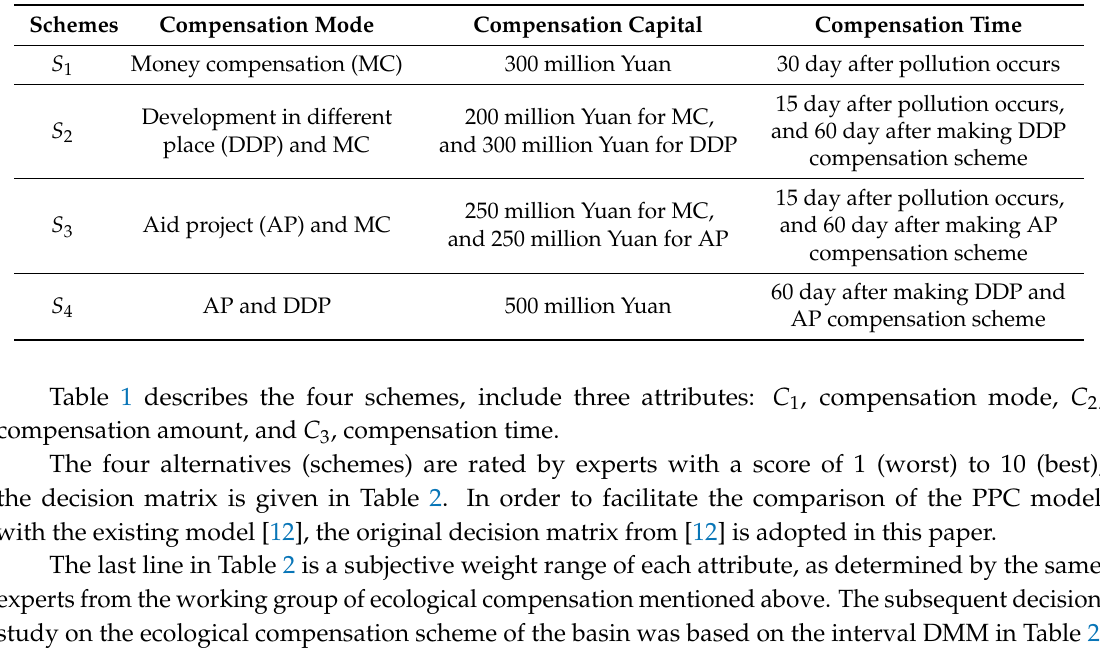
Table 1. Schemes of alternative ecological compensation